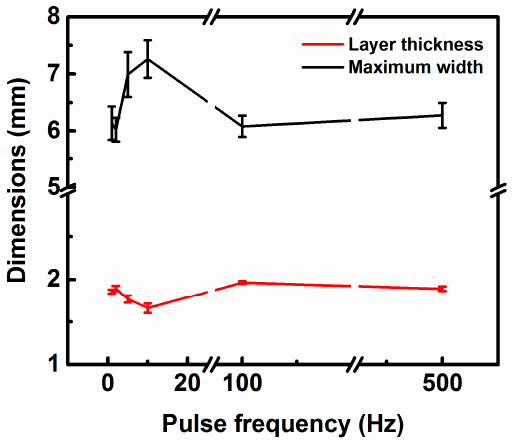
Figure 7. Effect of pulse frequency on the geometry of deposited layers.